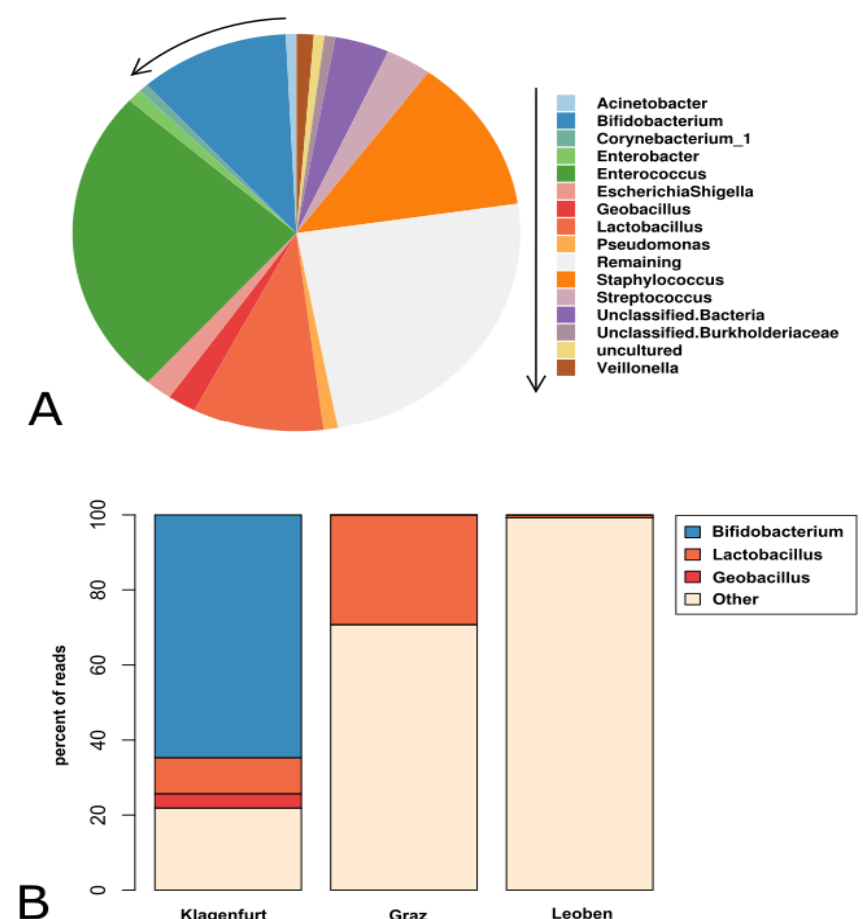
Figure 1. Main bacterial signatures in the premature infants’ gut. ( A ) Pie chart displaying the 15 most abundant microbial genera detected in fecal samples of 54 preterm infants from three centers during the first two weeks of life. ( B ) Relative abundance of signatures from Bifidobacterium, Lactobacillus, Geobacillus and other genera in samples from the three centers (K, G and L).